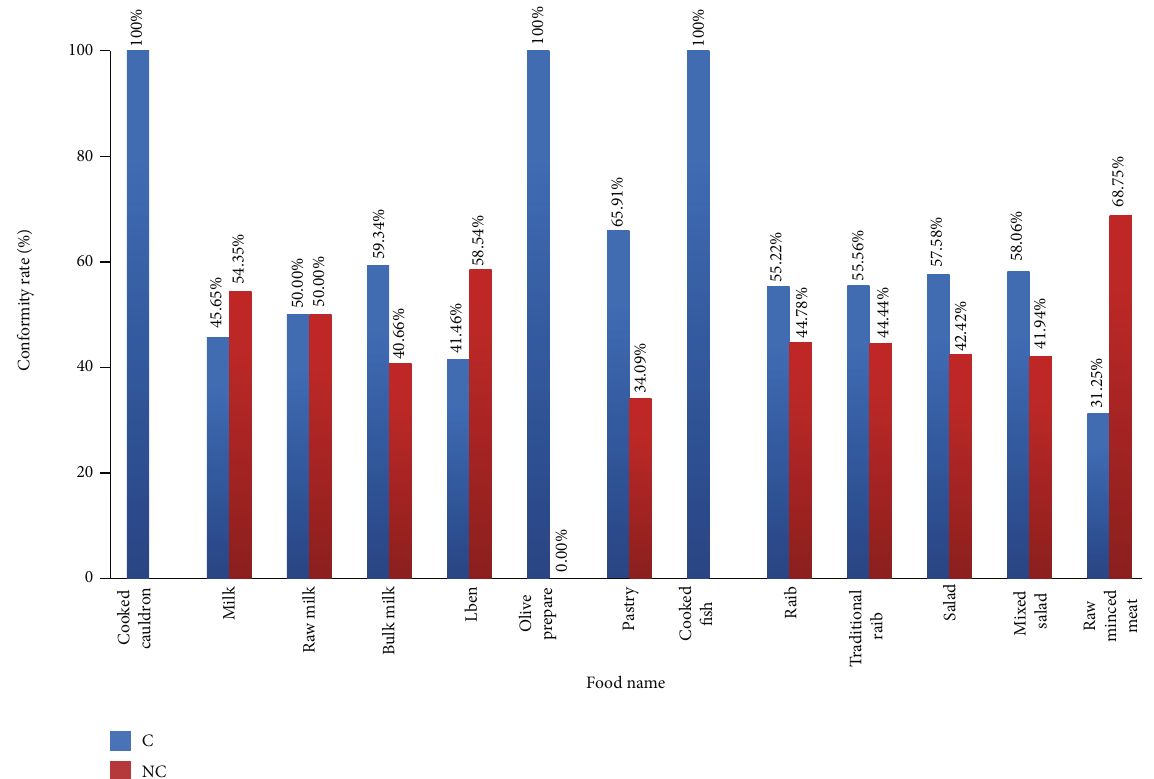
Figure 3: Conformity/non-conformity rate according to the food